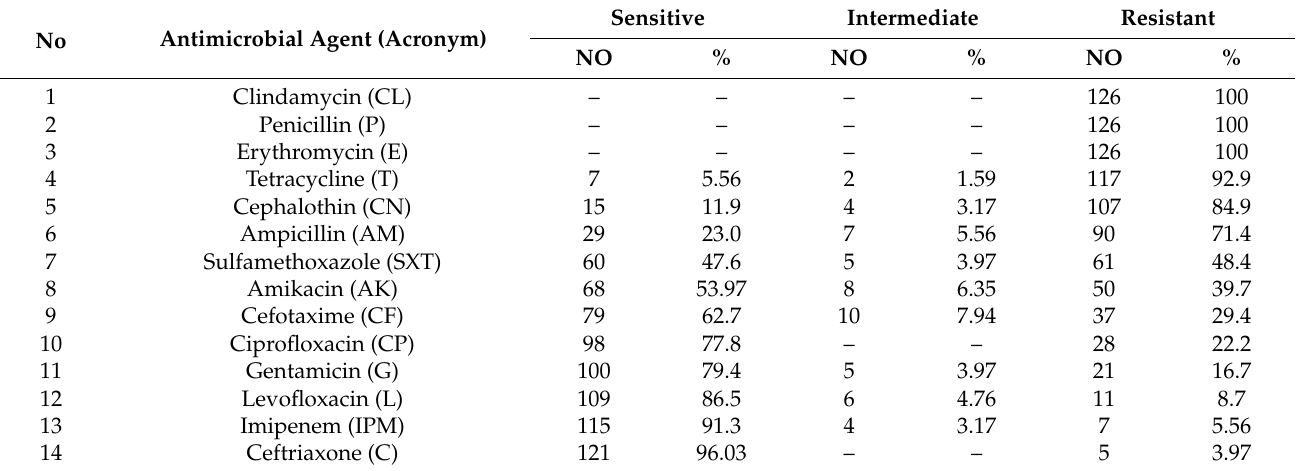
Table 2. Antimicrobial susceptibility of E. coli O157:H7 and O55:H7 strains ( n =